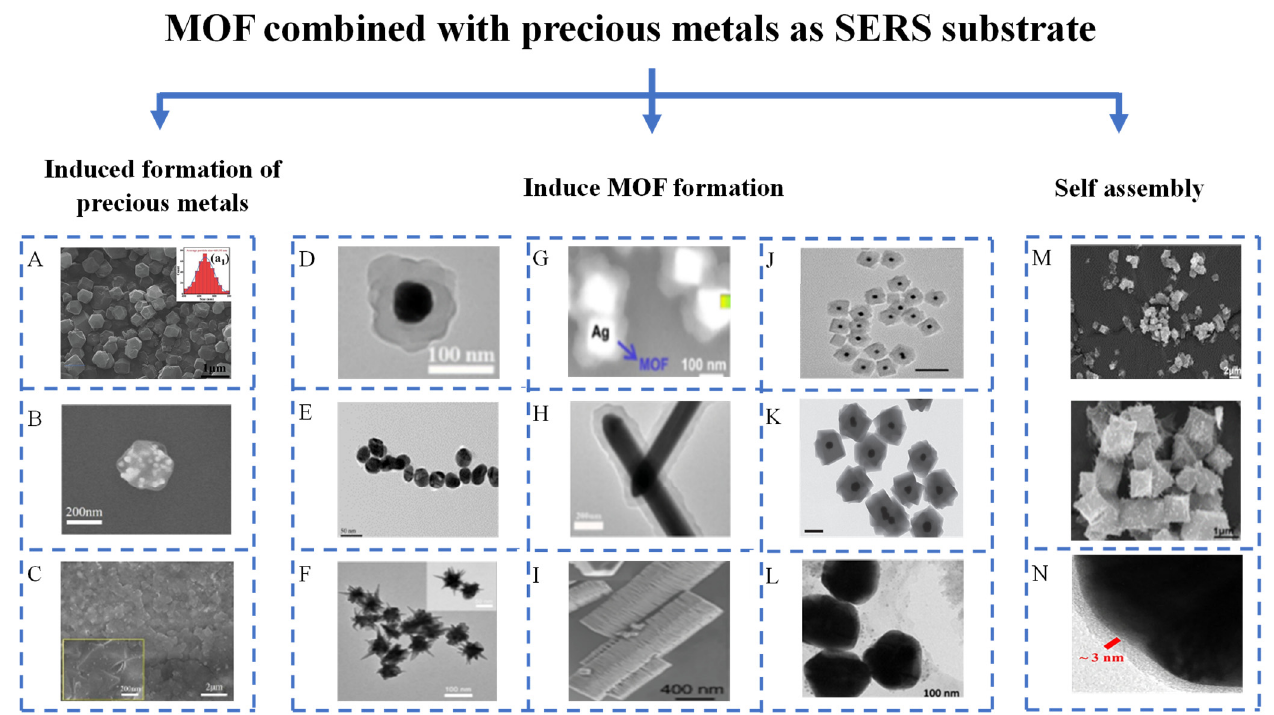
Figure 1. ( A – C ) SERS substrate synthesized by inducing precious metal nanoparticles to